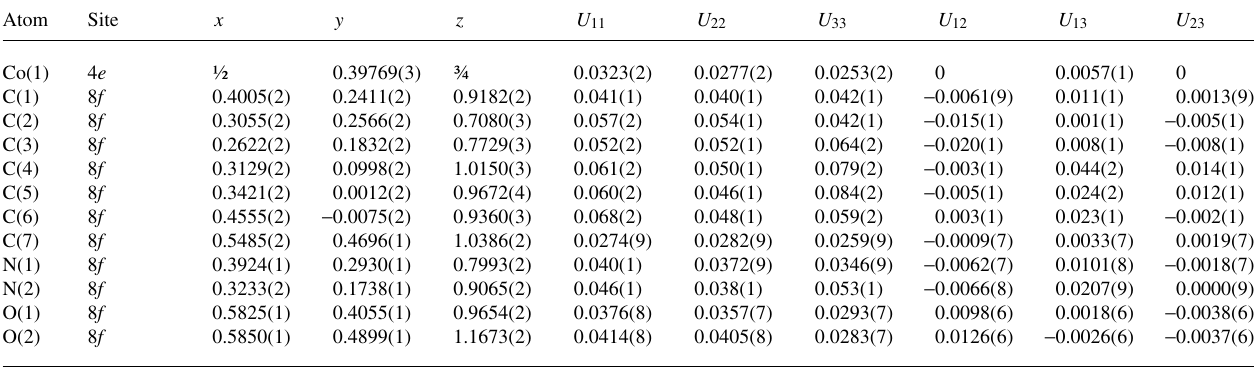
Table 3. Atomic coordinates and displacement parameters (in Å 2 )